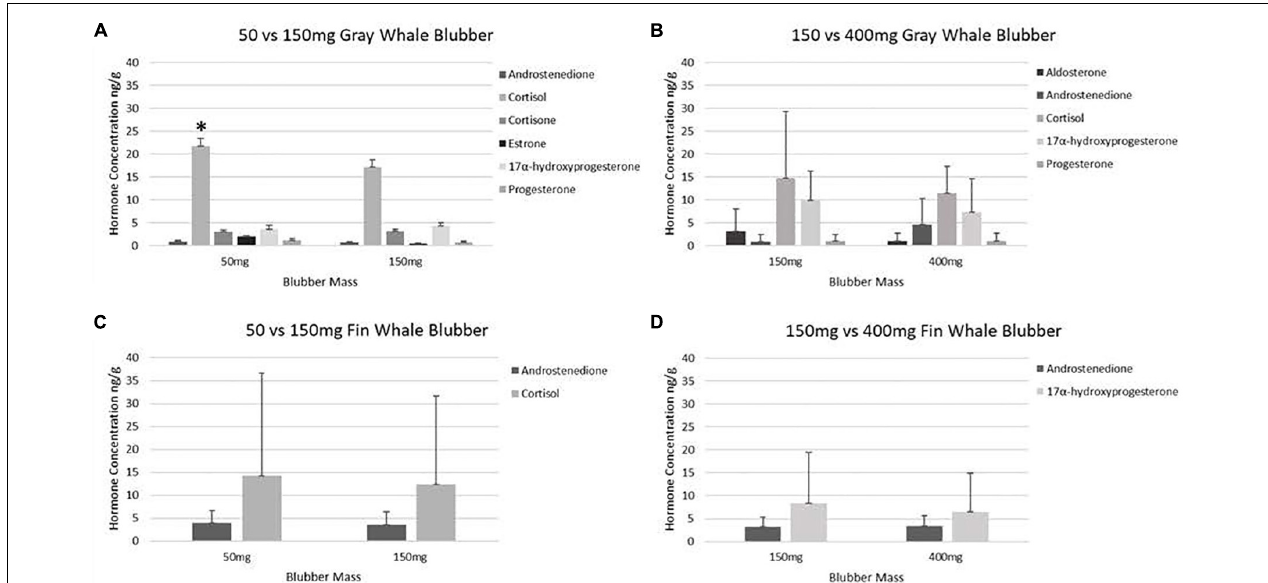
FIGURE 4 | Mean concentrations of hormones in paired blubber samples of gray and fin whales. Steroid hormone concentration comparisons between paired gray whale (A) ( n = 15), (B) ( n = 6), and fin whale (C) ( n = 6), and (D) ( n = 3) blubber masses ww. Concentrations below the LOD were designated as “zeros”. Hormones for which all data was below the LOD are not shown. An ∗ indicates significance ( p <